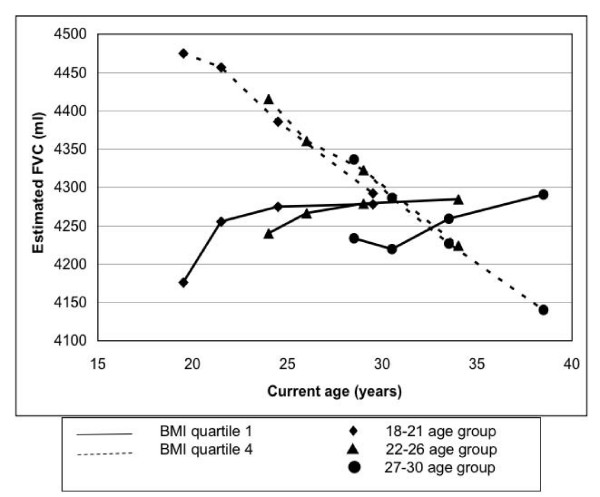
FVC in year 0 BMI quartiles across three birth cohorts: 18–21 years, 22–26 years, and 27–30 years at baseline, based on repeated measures linear regression analysis and adjusted for race, sex, current age, smoking status at year 0, asthma status, time, physical activity score at year 0, and alcohol consumption at year 0. The slope of FVC across time becomes increasingly negative with increasing year 0 BMI (p trend < 0.0001).